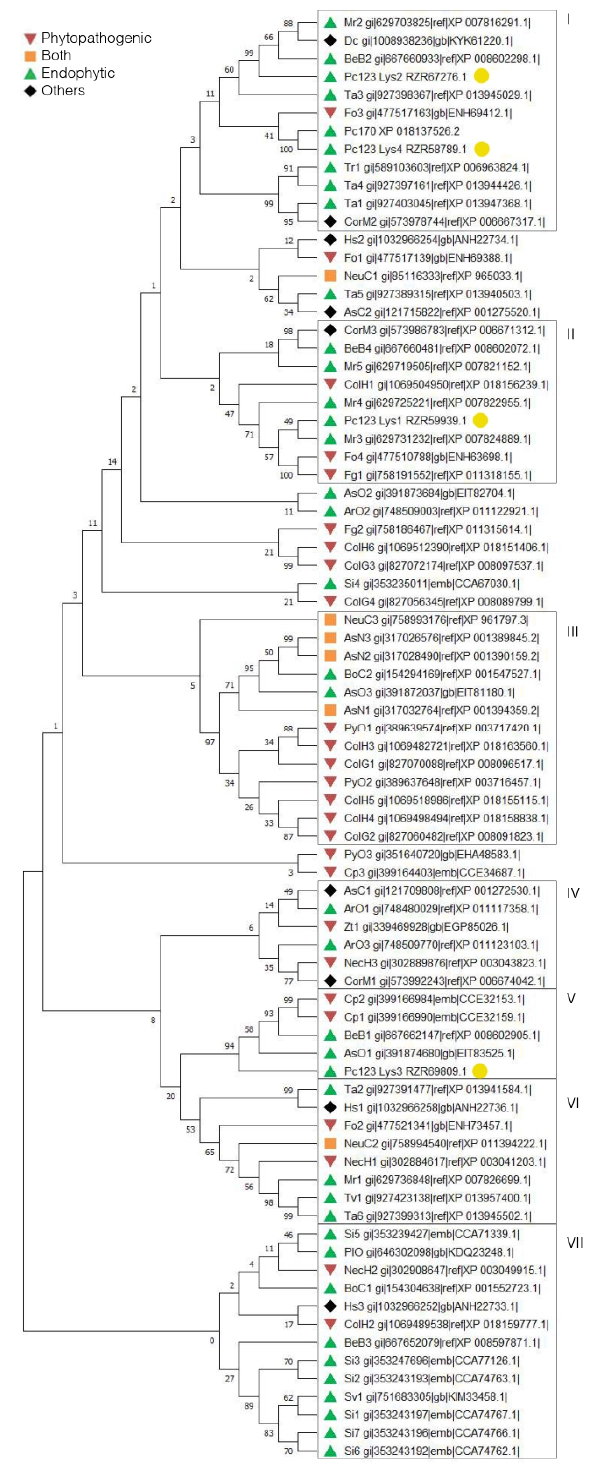
Figure 2. Fungal endophytes and phytopathogens can be grouped according to their putative LysM effector sequences. This phylogeny of putative LysM effectors contains 27 different organisms and 81 sequences. Phylogeny is grouped into lifestyles: endophytes, pathogens and both. Phylogenetic analysis was performed in MEGA X by aligning the sequences using ClustalW, with a Maximum Likelihood tree, 1500 Bootstraps and the JTT method. Abbreviations are listed in Table 1. Pc123 putative LysM effectors are marked with yellow dots.